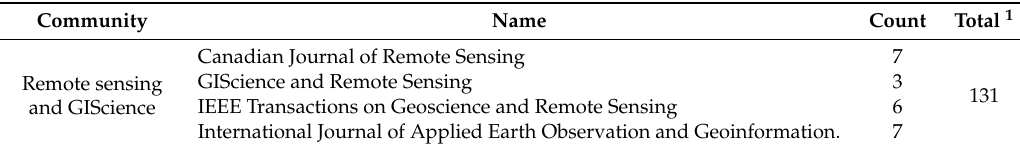
Table 1. Summary of literature sources from peer reviewed journal reviewed in this